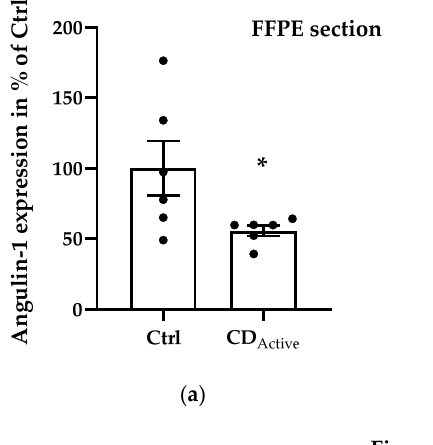
Figure 1. Scatter and bar plots of tight junction (TJ) protein mRNA expression analysis of human intestinal tissue. Mean value of controls (Ctrl) is set to 100%. ( a ) Angulin-1 is downregulated in active CD (28.26 ± 7.62%, n = 11) compared to Ctrl (100 ± 16.81%, n = 22, * p < 0.05) and remission patients (116.86 ± 27.87%, n = 5, * p < 0.05). ( b ) Angulin-2: Ctrl = 100 ± 21.85%, n = 24; CD Active = 37.63 ± 16.14%, n = 11; CD Rem = 97.44 ± 12.52%, n = 5). ( c ) Angulin-3: Ctrl = 100 ± 27.54%, n = 20; CD Active = 87.78 ± 46.96%, n = 8; CD Rem = 133.09 ± 44.91%, n = 5. ( d ) Tricellulin: Ctrl = 100 ± 16.75%, n = 22; CD Active = 67.87 ± 28.82%, n = 11; CD Rem = 114.90 ± 25.69%, n = 5. ( e ) Cldn-2 shows an increase in CDActive (256.28 ± 48.51%, n = 7) in comparison with Ctrl (100 ± 18.61%, n = 19, ** p < 0.01) and remission CD (76.67 ± 30.36%, n = 4, * p < 0.05). ( f ) Cldn-4: Ctrl = 100 ± 28.64%, n = 20; CD Active = 127.67 ± 39.31%, n = 11; CD Rem = 68.33 ± 29.68%, n = 5.